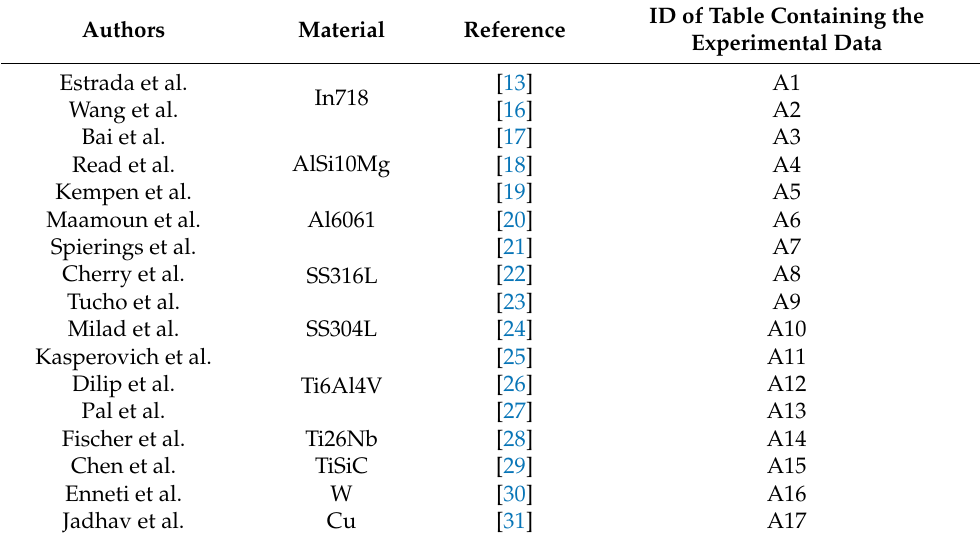
Table 1. Authors, material, reference and ID of table containing the adapted experimental data